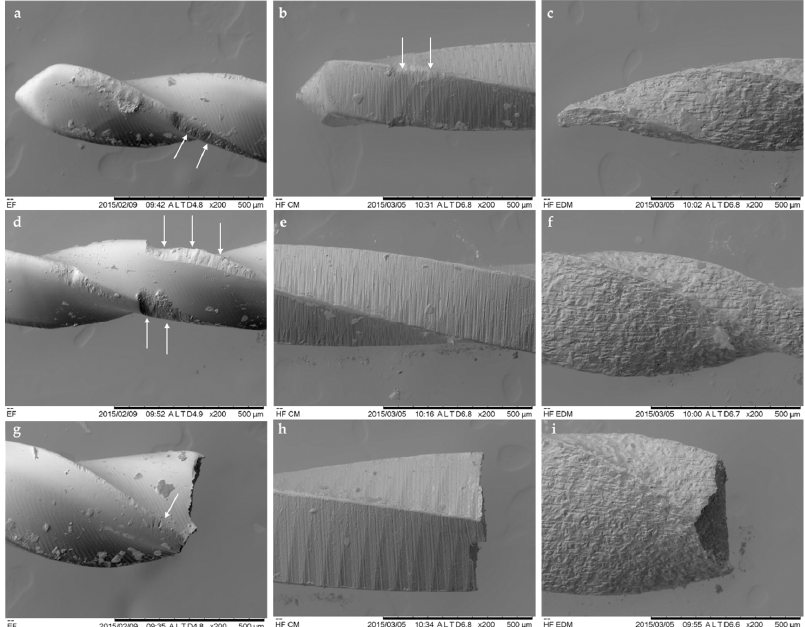
Figure 5. The SEM analysis under ×200 magnification revealed significant differences of the integrity of the instrument surfaces after cyclic fatigue test. The microscopic defects (white rows) were extensively evident on EF instruments ( a , d , g ); the CM files demonstrated minimal distortions ( b , e , h ), while the EDM instruments did not demonstrate any visible defects ( c , f , i ).